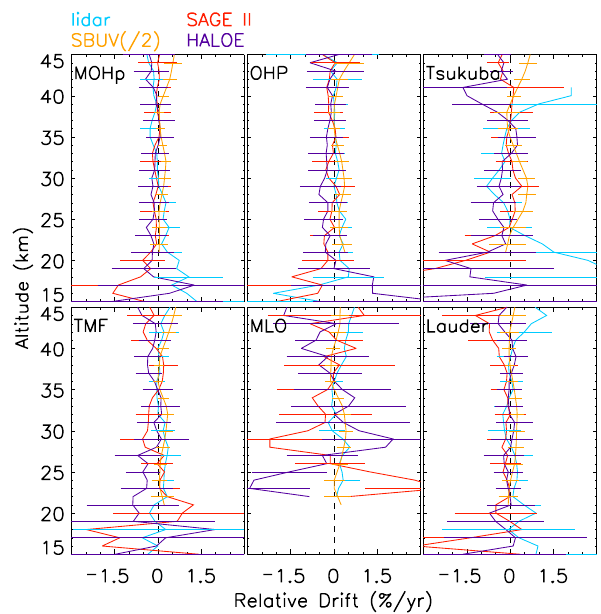
Fig. 7. The mean drifts estimated for the long-term data sets with respect to other long-term measurements as references. The error bars represent twice the average of the standard deviations of the slopes obtained from different